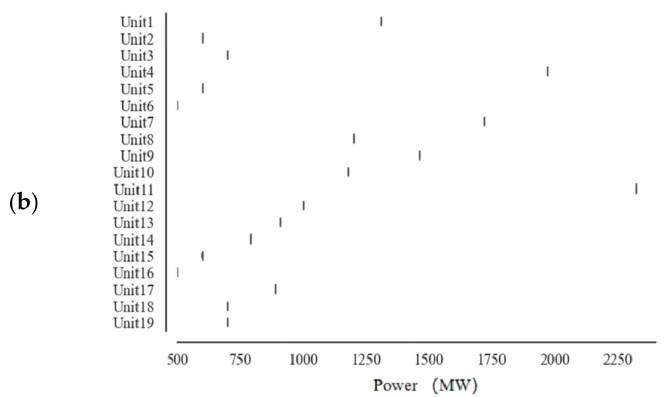
Figure 12. The volatility of the two cases: ( a ) is Case 1 and ( b ) is Case 2.